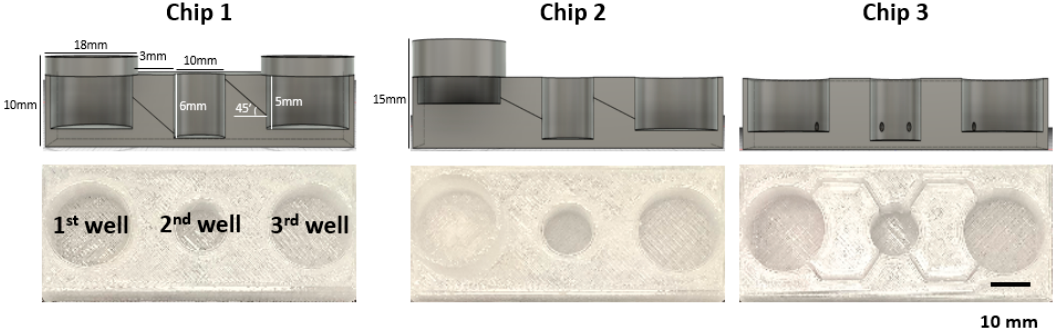
Figure 2. FPM chip design. Using the optimized infill condition, three different types of FPM designs were fabricated. All prototypes had the three wells: first well; media inflow or drug injection well, second well; organoid culture well, third well; another cell culture or media outflow well. Chip 1 had three wells of the same height with the tilted channel for material transfer by gradient force. The three wells of Chip 2 were located at different heights and connected by the tilted channel. Lastly, Chip 3 had the same height wells and the wells were connected by a non-tilted channel.